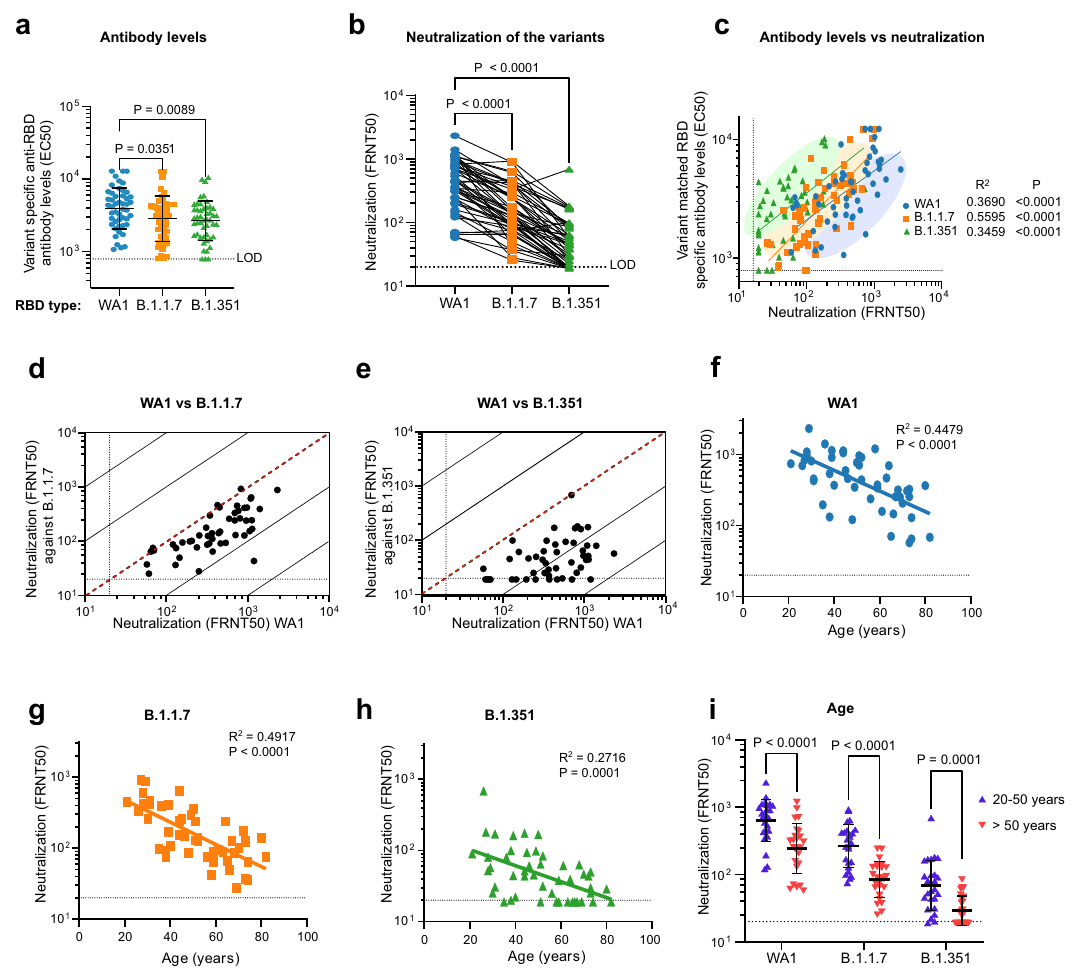
Fig. 1 Serum antibody levels of BNT162b2 vaccine recipients and potency of sera to neutralize SARS-CoV-2 variants. a Serum antibody levels (EC50) that recognize the spike RBD of the wild-type USA-WA1/2020 (WA1) (Blue circles), B.1.1.7 (Orange squares), and B.1.351 (Green triangles) variants are shown. The RBD-B.1.1.7 carries the N501Y mutation, the only RBD mutation present in the B.1.1.7 variant. The RBD-B.1.351 has the K417N, E484K, and N501Y mutations which are the only three RBD mutations present in the B.1.351 variant. n = 51 biologically independent samples. b Comparison of neutralization titers (FRNT50) between WA1, B.1.1.7 ( P = 0.0351) and B.1.351 ( P = 0.0089) for BNT162b2 vaccinee sera. n = 50 biologically independent samples. c Correlation of variant matched RBD-speci fi c antibody levels and neutralization titers (FRNT50) of the WA1 virus and the two variants. d , e Correlations between neutralization titers of the B.1.1.7 ( d ) and B.1.351 ( e ) variants with the WA1 virus. The dotted diagonal lines indicate identical neutralization, and the solid diagonal black lines indicate 10-fold differences in neutralization. f – h Correlation between participant age and neutralization titer against WA1 ( f ) ( P < 0.0001), B.1.1.7 ( g ) ( P < 0.0001), and B.1.351 ( h ) ( P < 0.0001). n = 50 biologically independent samples. i Effect of age range 20 – 50 years (blue triangle) and >50 years (red inverted triangle) on the neutralization potency among the BNT162b2 vaccine recipients (WA1,B.1.1.7 P < 0.0001, B.1.351 P = 0.0001). n = 25 biologically independent samples per age group. For a , b , f – i , data are presented as the mean ± SD of log transformed values; P values are two-sided and include a Š idák multiple comparison correction. All experiments were performed in